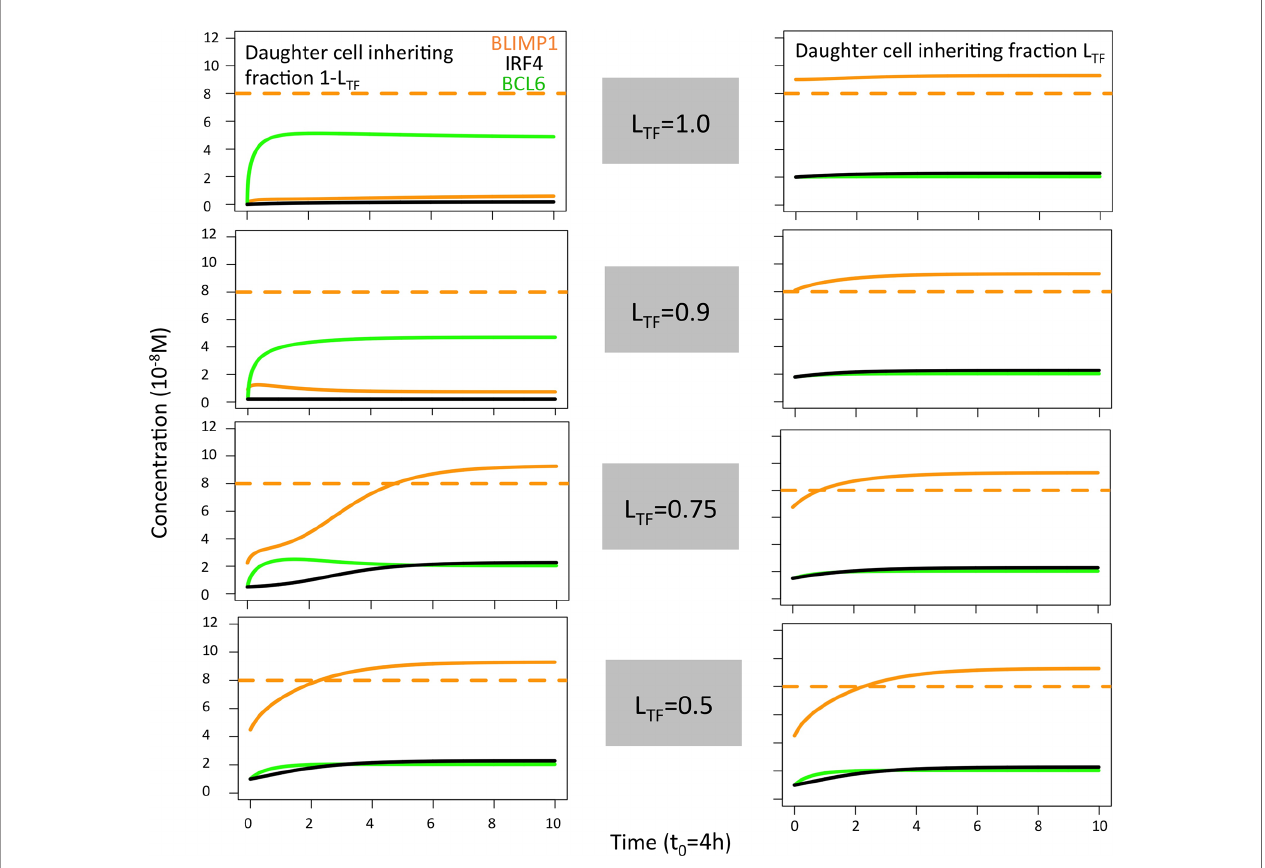
FIGURE 5 | Solution curves based on the GRN (ODE model) for BLIMP1 (orange), BCL6 (green), and IRF4 (black) in two daughter cells. The initial TF concentrations were based on the concentration of the parent cell (BLIMP1 = 8, BCL6 = 2, IRF4 = 2) and the different polarity levels (L TF = 1.0, L TF = 0.9, L TF = 0.75, and L TF = 0.5; Table 2